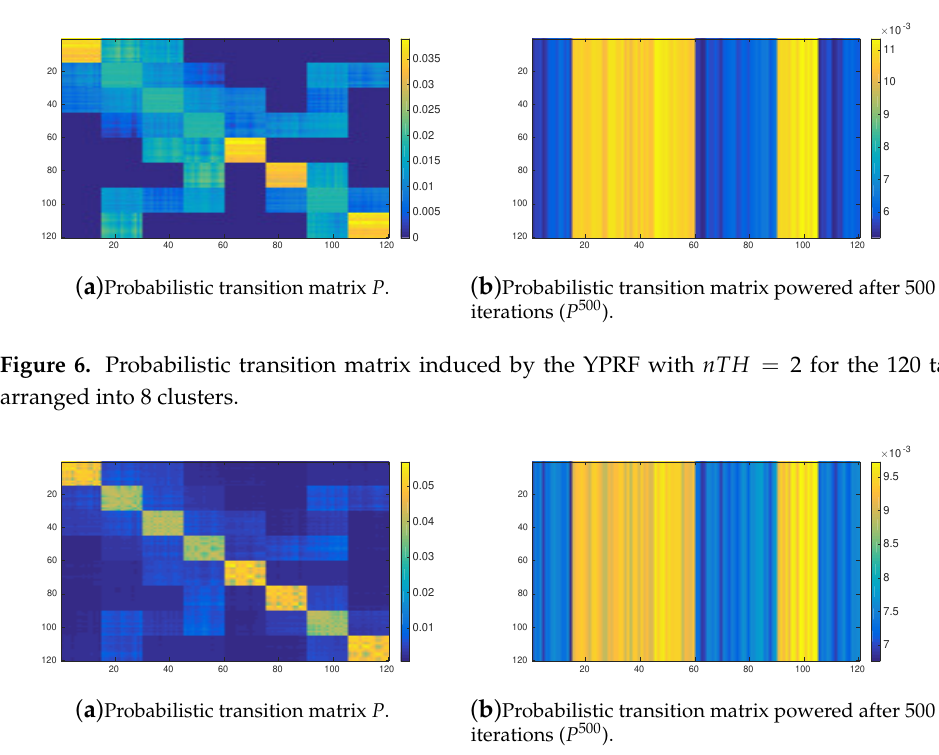
Figure 7. Probabilistic transition matrix induced by the OPRF with nTH = 8 for the 120 tasks arranged into 8